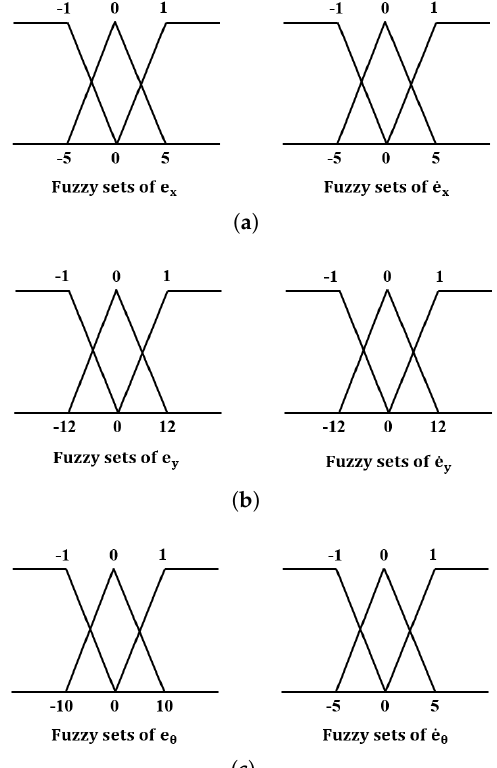
Figure 2. The fuzzy sets of the input language variables. ( a ) Learning a given e x and ˙ e x . ( b ) Learning b given e y and ˙ e y . ( c ) Learning c given θ and ˙ θ .